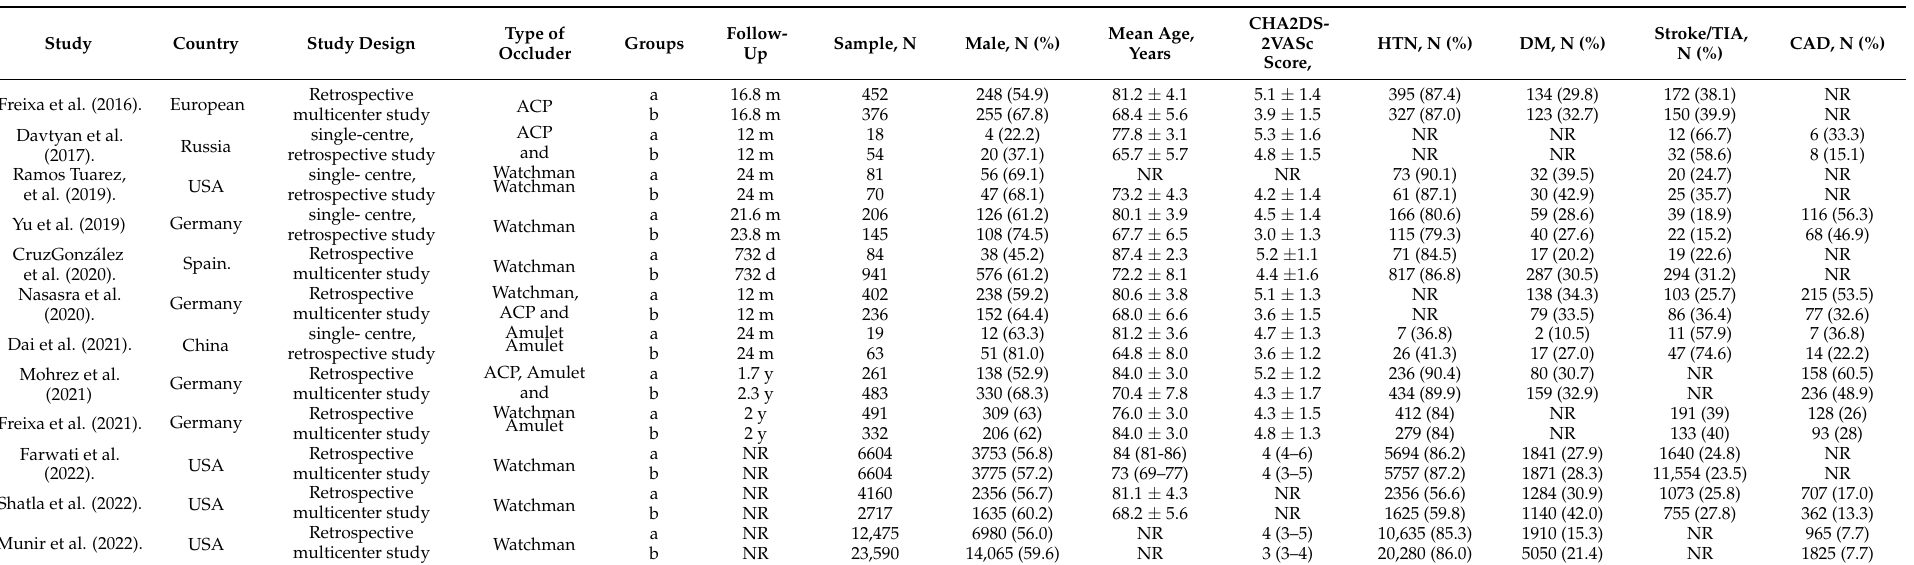
Table 1. Characteristics of the 12 included